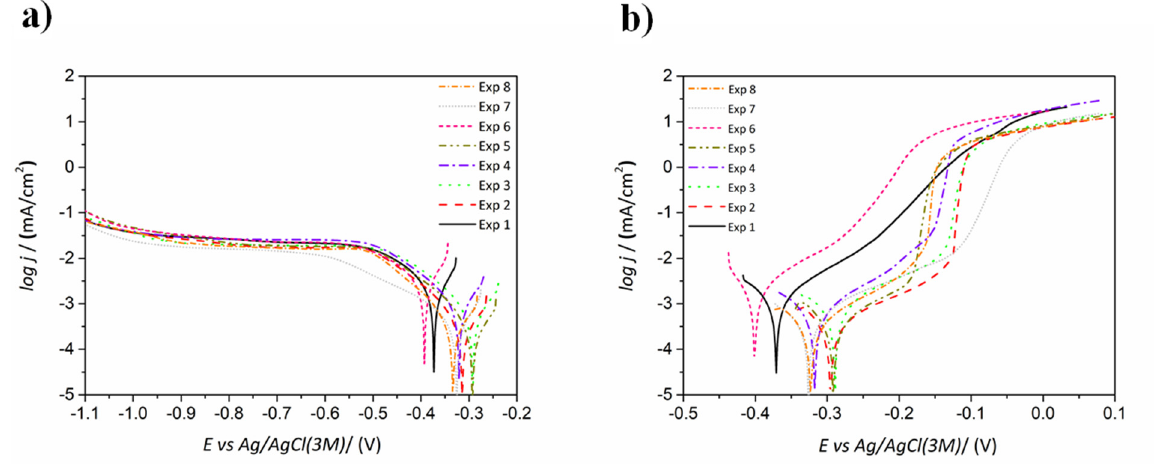
Figure 7. ( a ) Cathodic and ( b ) anodic branches of the polarization curves for the various ENP coatings obtained through experiments 1–8.